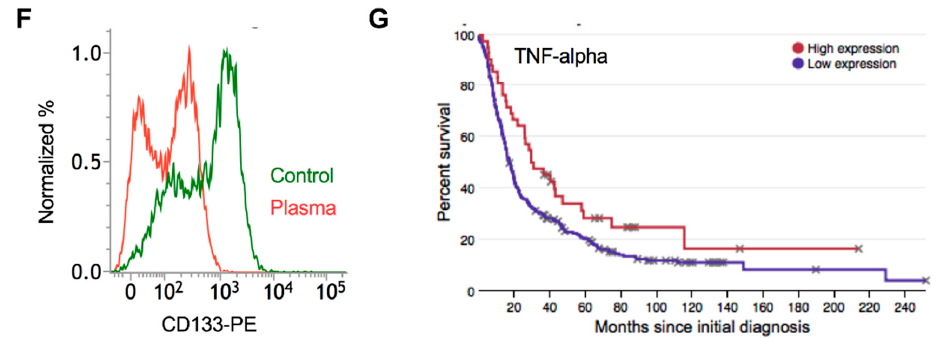
Figure 7. Plasma treatment shows efficacy to suppress tumorigenic potential in vivo through macrophage stimulation. ( A ) U87 glioma cells were subcutaneously injected in mice and tumor volume was calculated in control and plasma-treated groups. Plasma-treated medium (PAM) was prepared with 10 min plasma treatment. ( B ) Tumor weight was also estimated in similar groups as mentioned above. Represented images were displayed in the right side. ( C ) IHC images of EMT markers such as E-cadherin, N-cadherin and Vimentin in control and plasma treated groups. ( D ) DAB staining images of TNF- α , CD86 (M1 macrophage marker) in control and plasma treated groups. ( E ) qPCR analysis of E-cadherin, N-cadherin and Vimentin gene expression. ( F ) Flow cytometry for the CD133-positive population in glioma cells extracted from mice xenografts. ( G ) TCGA analysis of glioma patient’s cohorts based on low and high expression of TNF- α . Scale bar = 50 µ m. Error bars represent the mean ± S.D. of triplicate samples. * p < 0.05 and ** p <